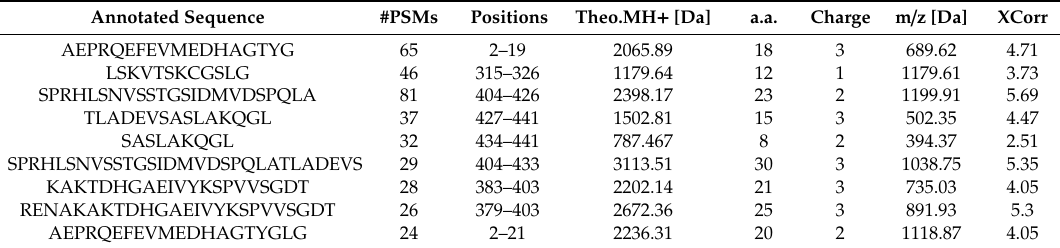
Table 1. Selected human tau-441 calpain-mediated proteolytic peptides from purified protein digestion identified by nano-liquid chromatography-tandem mass spectrometry (nLC-MS / MS). Annotated Sequence